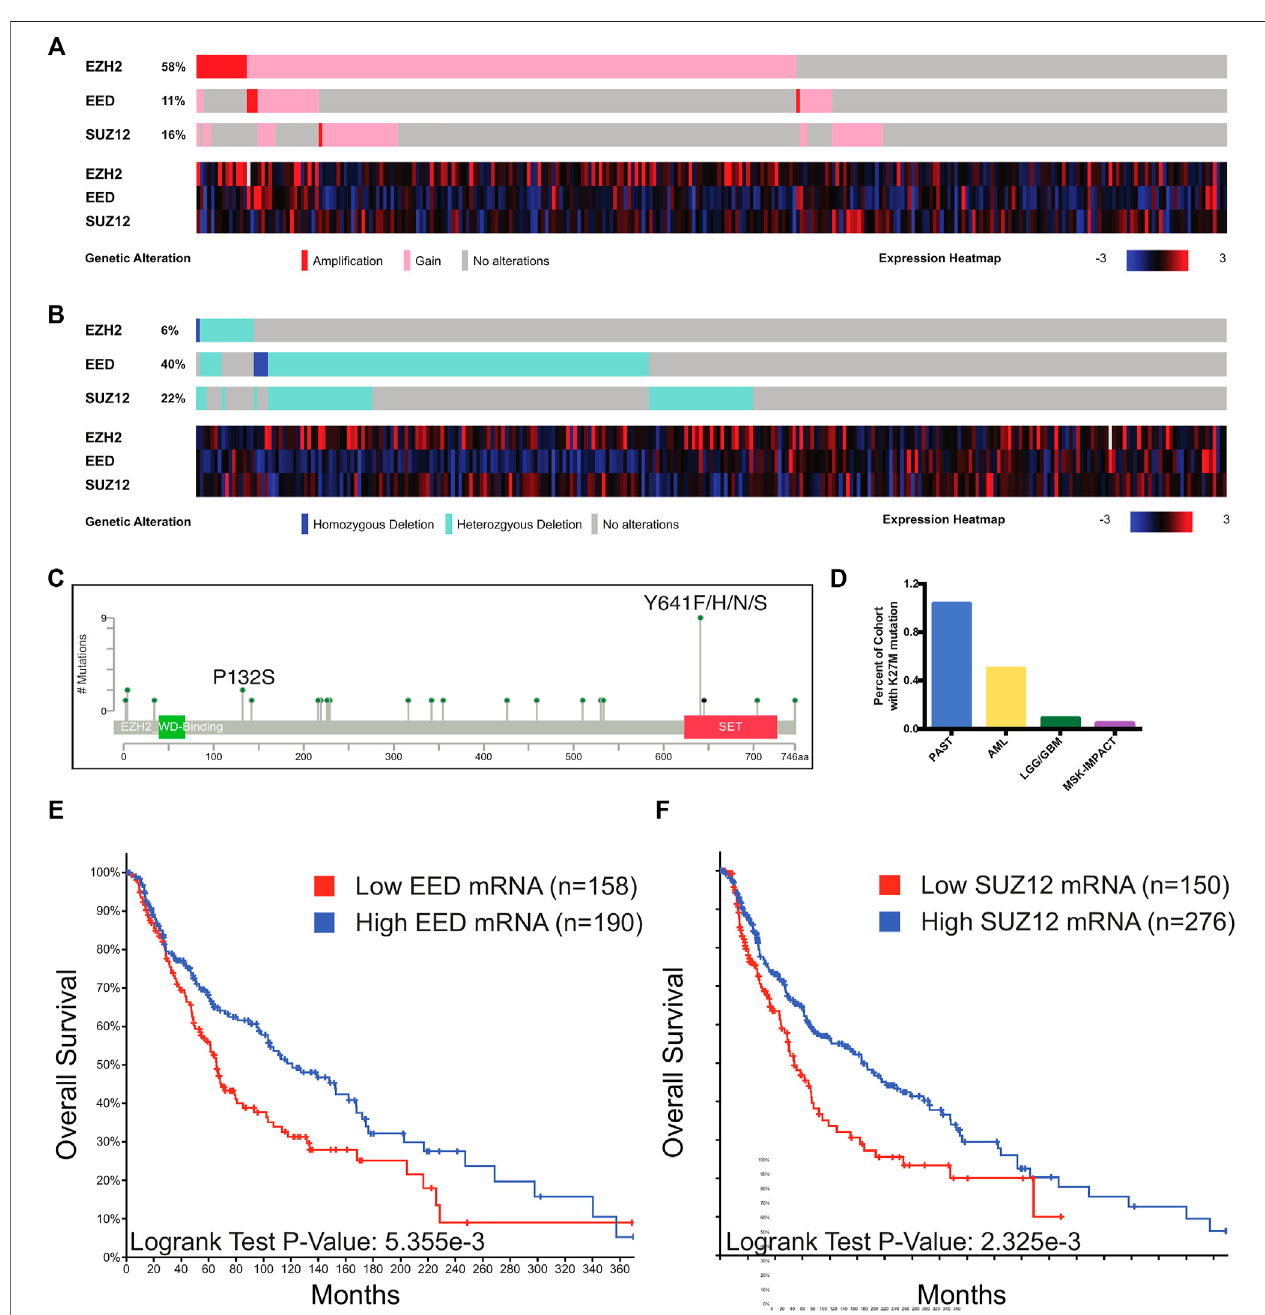
FIGURE4| PRC2 alterationsinmelanoma. (A , B) OncoprintoutputofTCGA melanoma datafromcBioPortal.Top, chromosomalalterationsinPRC2components areshown.Below, heatmapwithmRNA levelsofPRC2 components. (C) LollipopplotofmutationsinEZH2.Recurrent mutationswithknowneffects oncatalytic activity are denoted. (D) Percentage of cases from TCGA cohorts with the K27M mutation in any H3 gene. PAST, pilocytic astrocytoma; AML, acute myeloid leukemia; LGG/ GBM, low-grade glioma/glioblastoma. Of the fi ve MSK-IMPACT cases, n = 1 diffuse intrinsic pontine glioma; n = 1 glioma; n = 1 high-grade glioma; n = 1 glioblastoma; n = 1 primary melanoma. (E , F) Strati fi cation of survival of human melanoma patients based on EED (E) and SUZ12 (F) mRNA levels in TCGA melanoma cases with expression data. Cases with low EED expression have mRNA expression less than 0.6 standard deviations below the mean. Cases with low SUZ12 expression have mRNA expression less than 0.5 standard deviations below the mean. Plots generated with cBioPortal. p -value calculated from the Log-Rank Test.